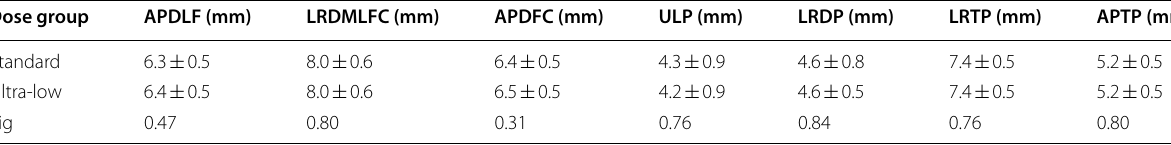
Table 3 Measurement parameters of 3D printed model Dose group Standard